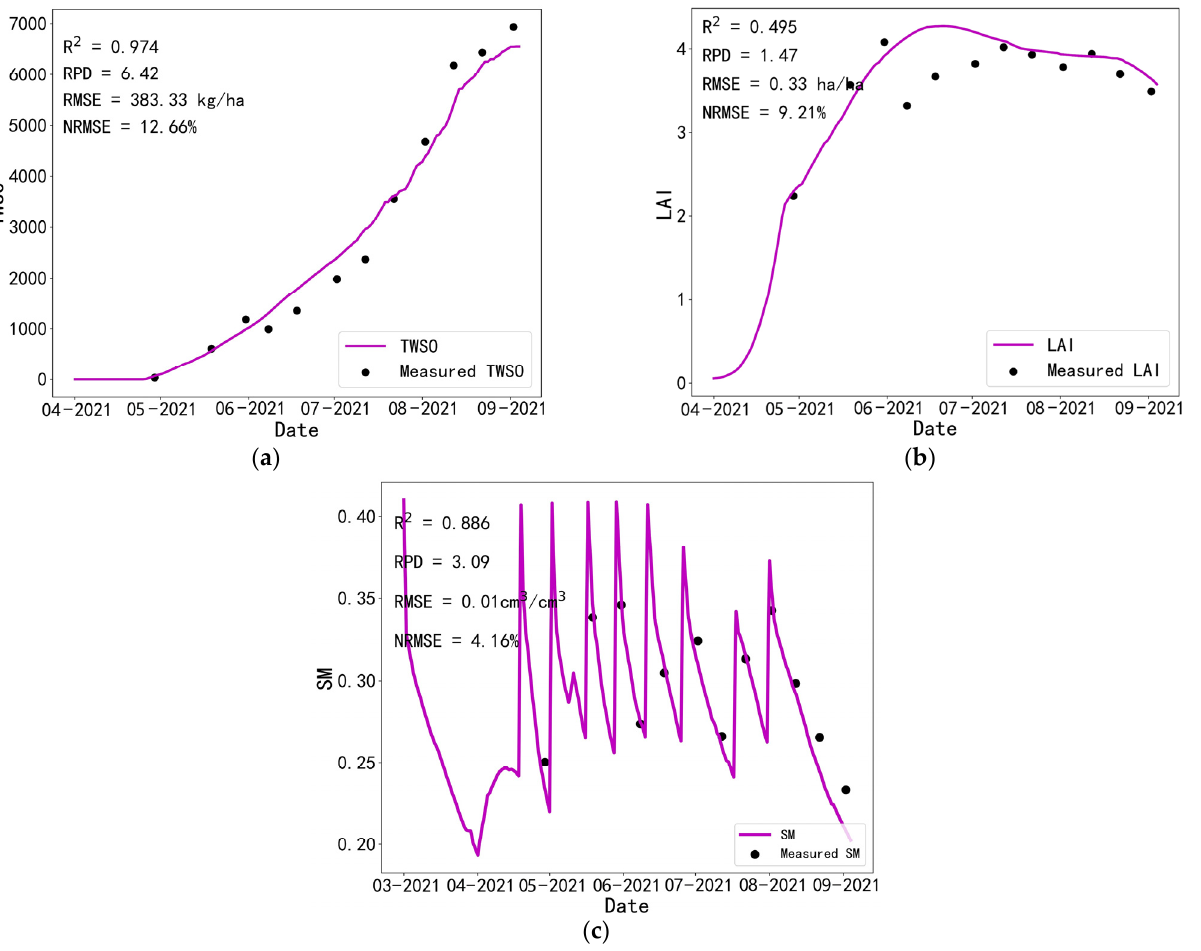
Figure 6. Simulated and measured TWSO ( a ), LAI ( b ) and SM ( c ) based on the unmodified WOFOST model.